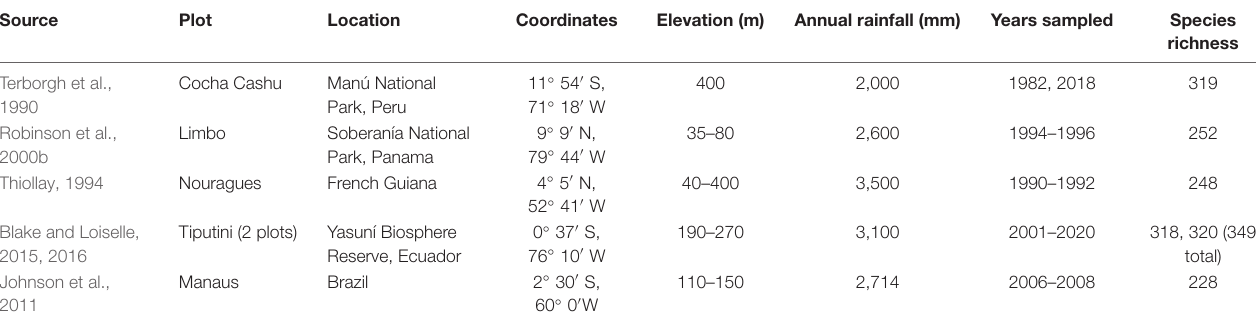
TABLE 1 | Summary of the ∼ 100-ha plots used to characterize Neotropical bird communities, including their locations, basic environmental characteristics, geographic coordinates, range of years sampled, and species richness. Source Plot Location